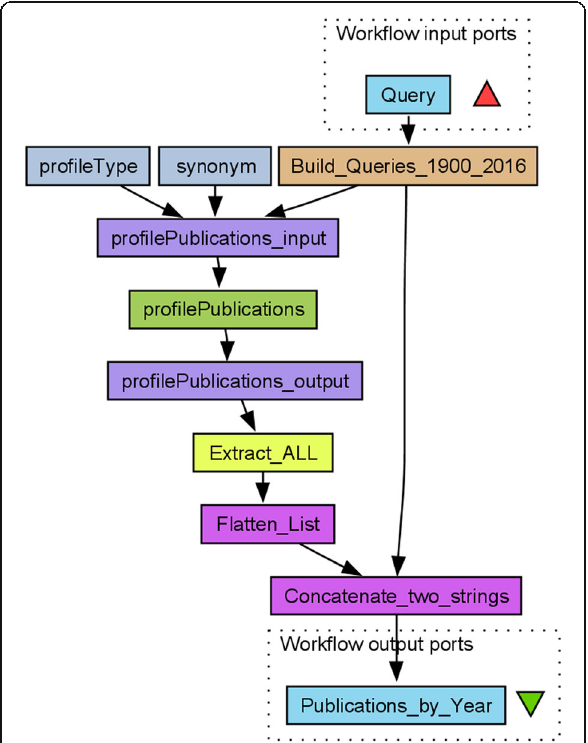
Fig. 1 The profilePublications_over_time workflow. This profilePublications_over_time Taverna workflow used to collect publication year data on publications of all types and on the topic defined by the input